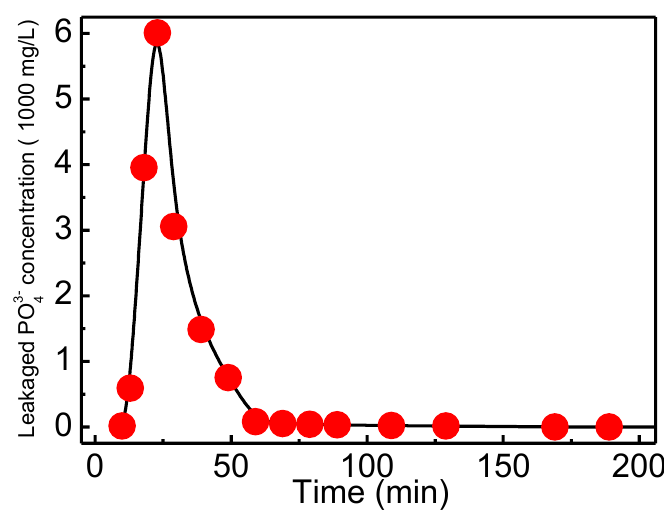
Figure 11. The elution curve at flow rate 0.25 mL/min.